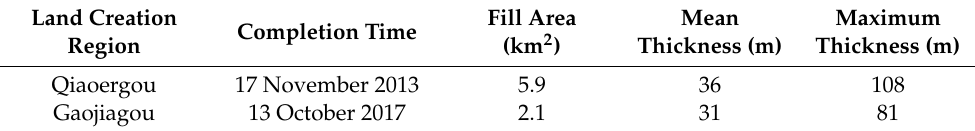
Table 2. The fill thicknesses for the two main valley-filling areas.